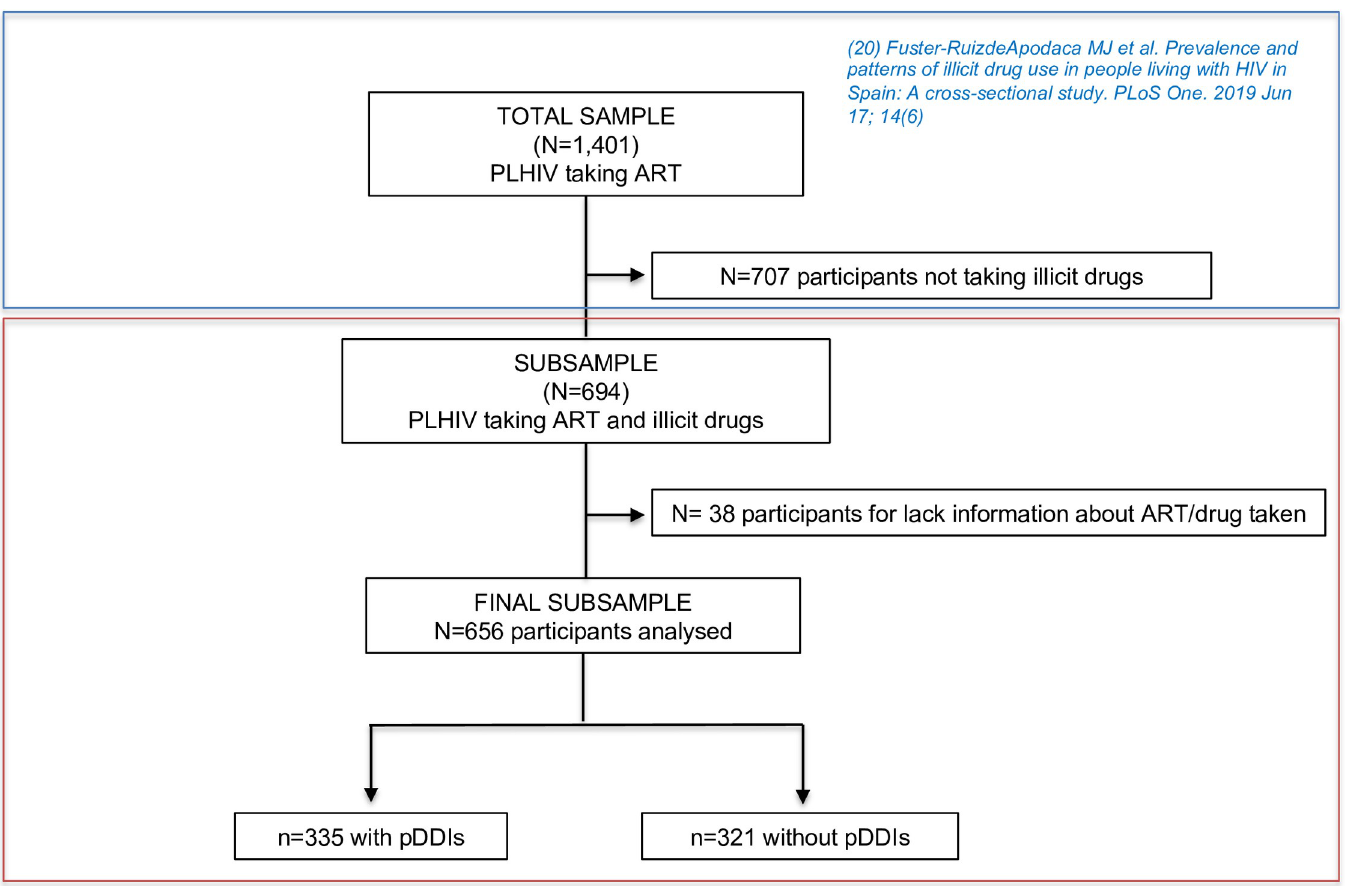
Fig 1. Study sampling. PLHIV: people living with HIV; ART: antiretroviral therapy; pDDIs: potential drug-drug interactions; N: patients; n: number of pDDIs.